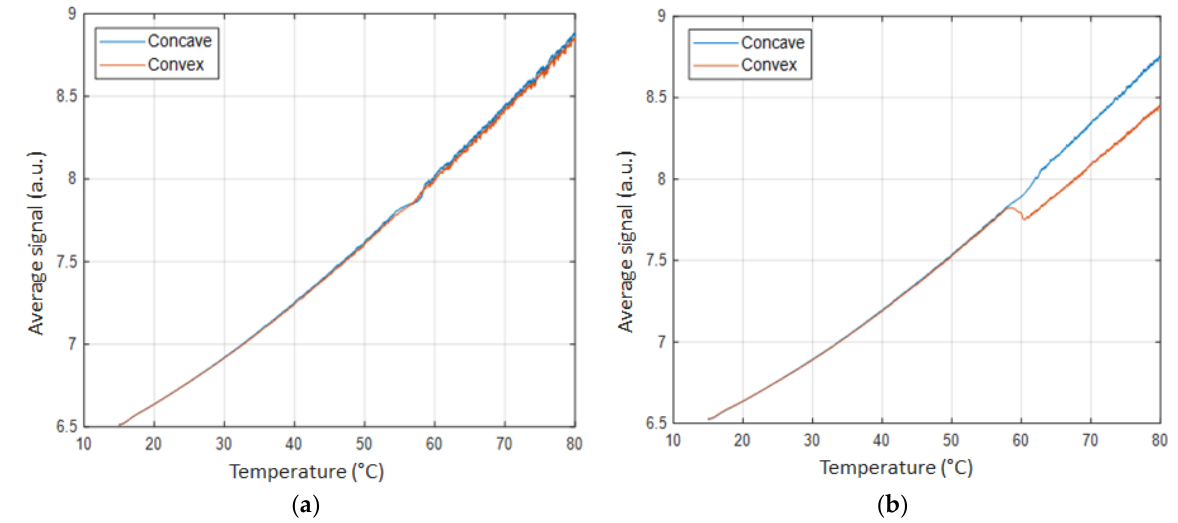
Figure 3. Evolution of the average signal according to temperature and the surface geometry for a sample of: ( a ) Myristic acid; ( b ) 1-Octadecanol.